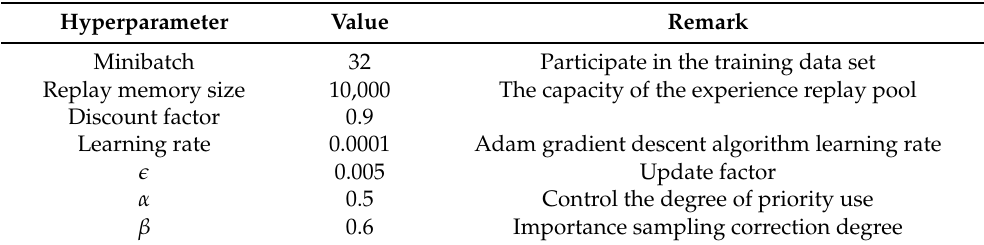
Table 1. Algorithm Hyperparameter Settings In Cartpole Environment. Hyperparameter Value